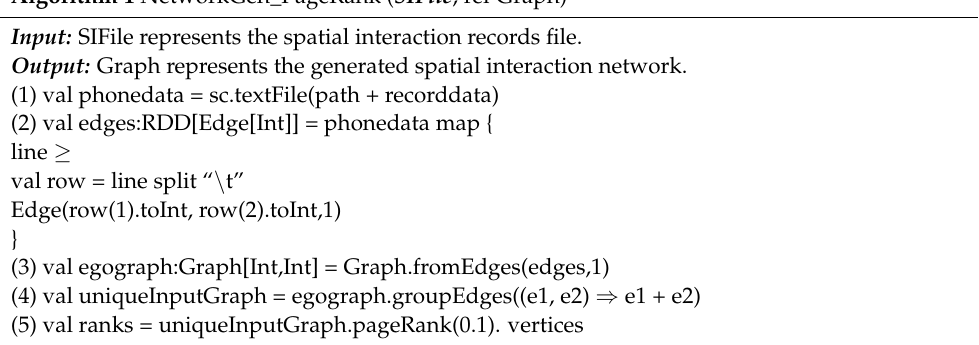
Algorithm 1 NetworkGen_PageRank ( SIFile , ref